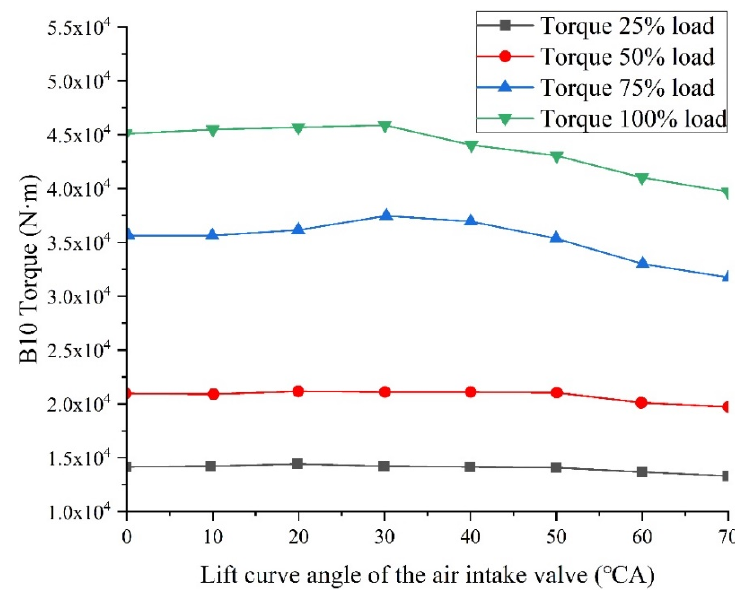
Figure 11. The power influence when Miller degree > 0.